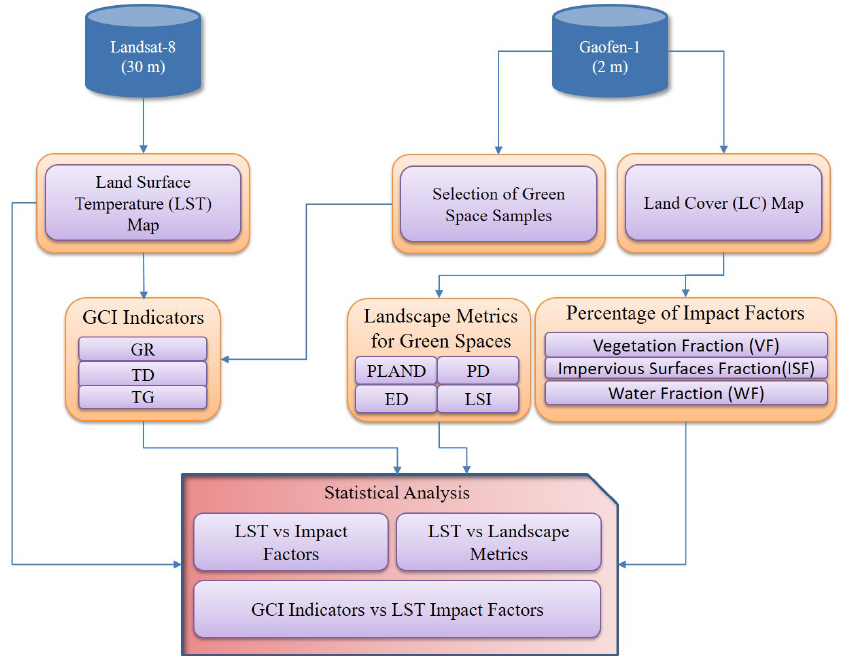
Figure 2. Methodological framework. ED: Edge Density; GCI: Green Space Cool Island; GR: Green Space Range; LSI: Landscape Shape Index; LST: Land Surface Temperature; PD: Patch Density; PLAND: Percentage of Landscape; TD: Temperature Difference; TG: Temperature